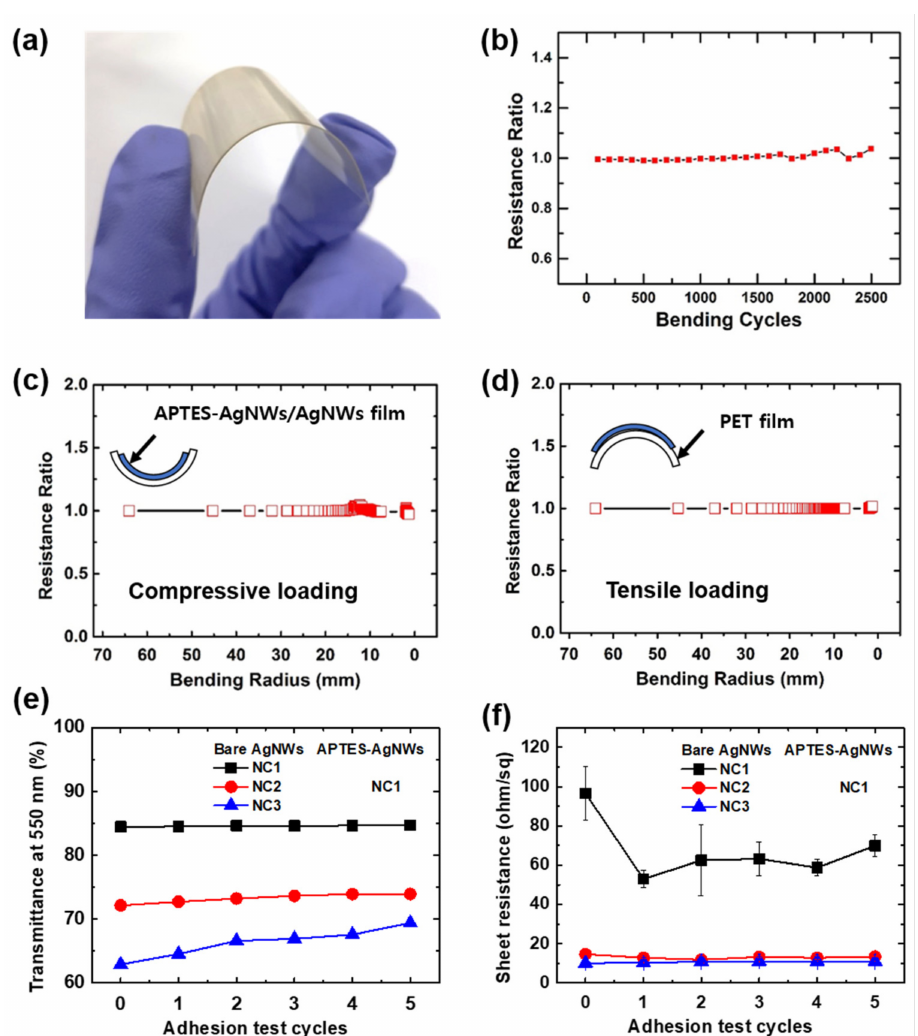
Figure 9. ( a ) Photograph of the APTES-AgNWs/AgNWs composite film deposited on a PE substrate. ( b ) Relative sheet resistance of the APTES-AgNWs/AgNWs composite film deposited on a PE substrate as a function of the number of compressive bending cycles. Relative sheet resistance of the APTES-AgNWs/AgNWs composite film with respect to the bending radius on a PE substrate as under the ( c ) compressive and ( d ) tensile loading. ( e ) Transmittance at λ = 550 nm and ( f ) sheet resistance of the APTES-AgNWs/AgNWs composite films as a function of the number of tape test cycles. The bare AgNWs networked films were deposited on the PE substrate using 20 µ L of the 0.5 wt.% AgNWs solution at NC = 1–3. The APTES-AgNWs were deposited on the bare AgNWs using 8 µ L of the 0.32 wt.% APTES-AgNW suspension at NC =